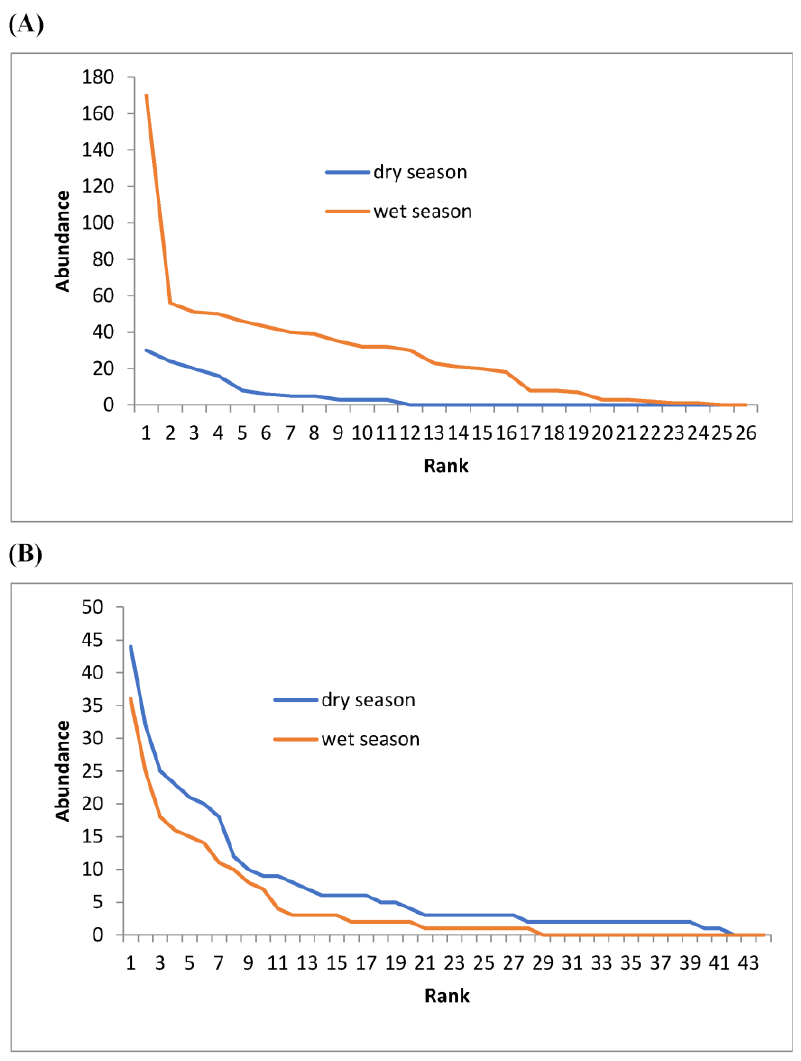
Figure 6. Rank–abundance diagram for amphibians ( A ) and reptiles ( B ) at the study area in Togo during the dry and wet seasons.